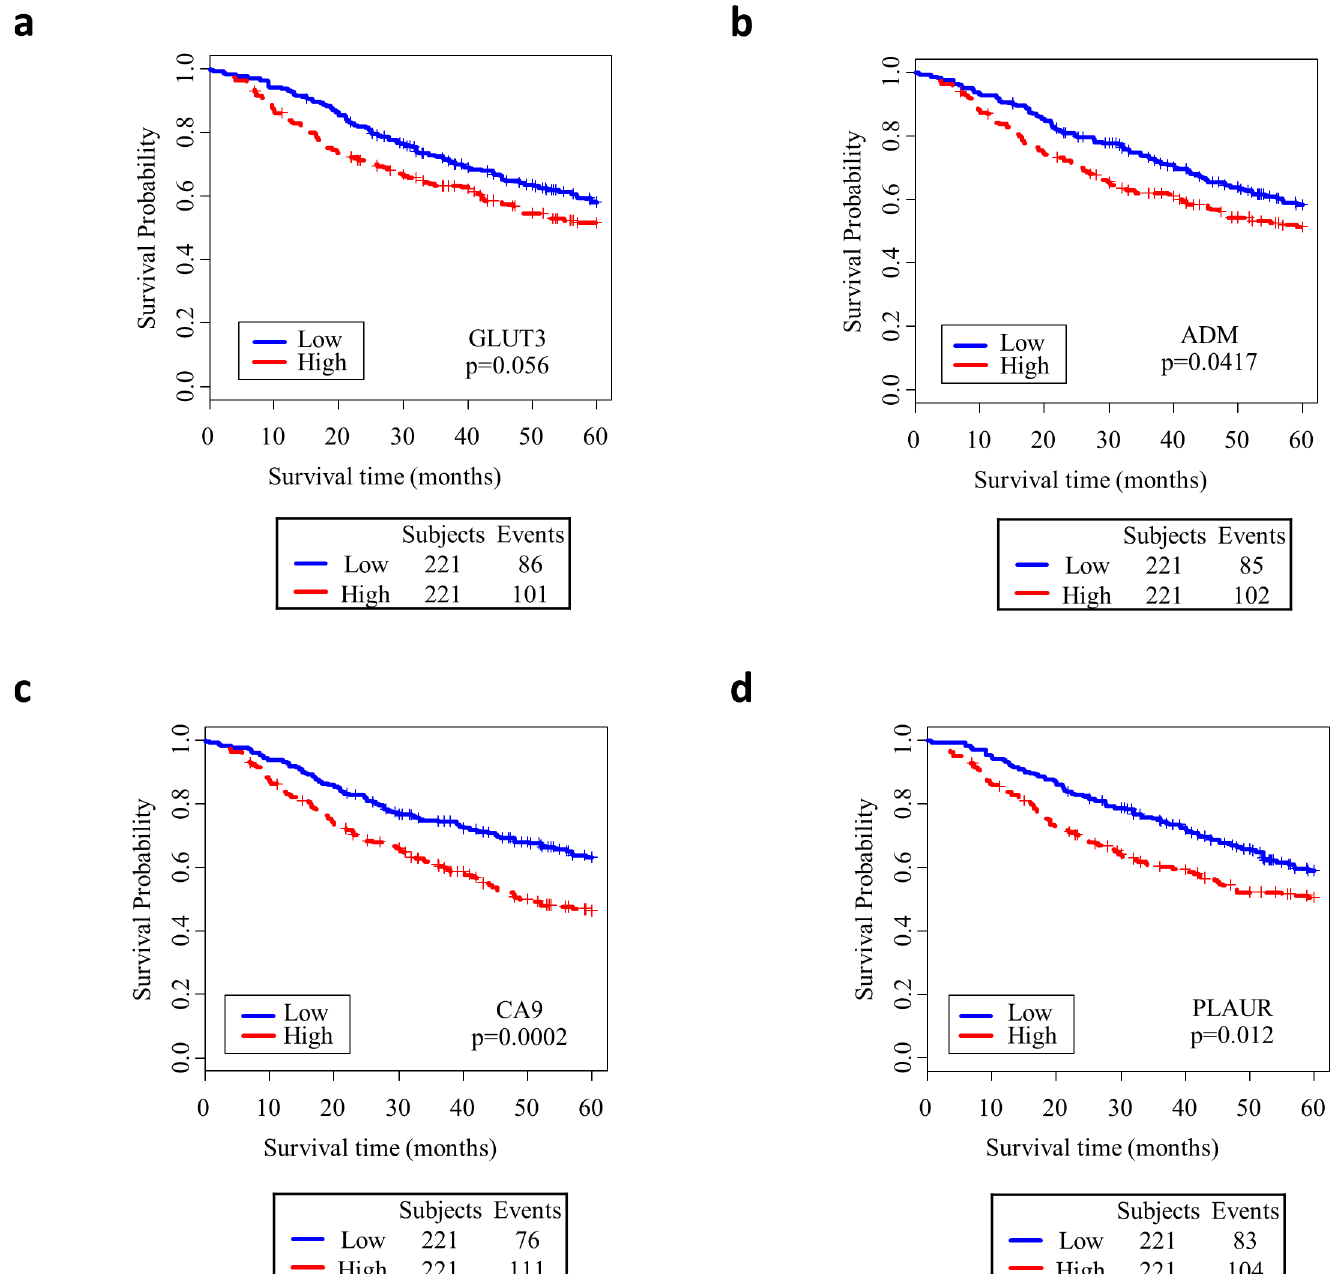
Fig 3. Kaplan-Meier survivor curves and log-rank test of selected targets of HIF signaling in prognostic validation cohort (N = 442) using median gene expression as cutoff to divide low and high expression. Downstream targets of HIF including (a) GLUT3 , (b) ADM , (c) CA9 ,and (d) PLAUR were associated with worse survival. Genes were selected according to validated MSigDB gene sets related to hypoxia signaling.